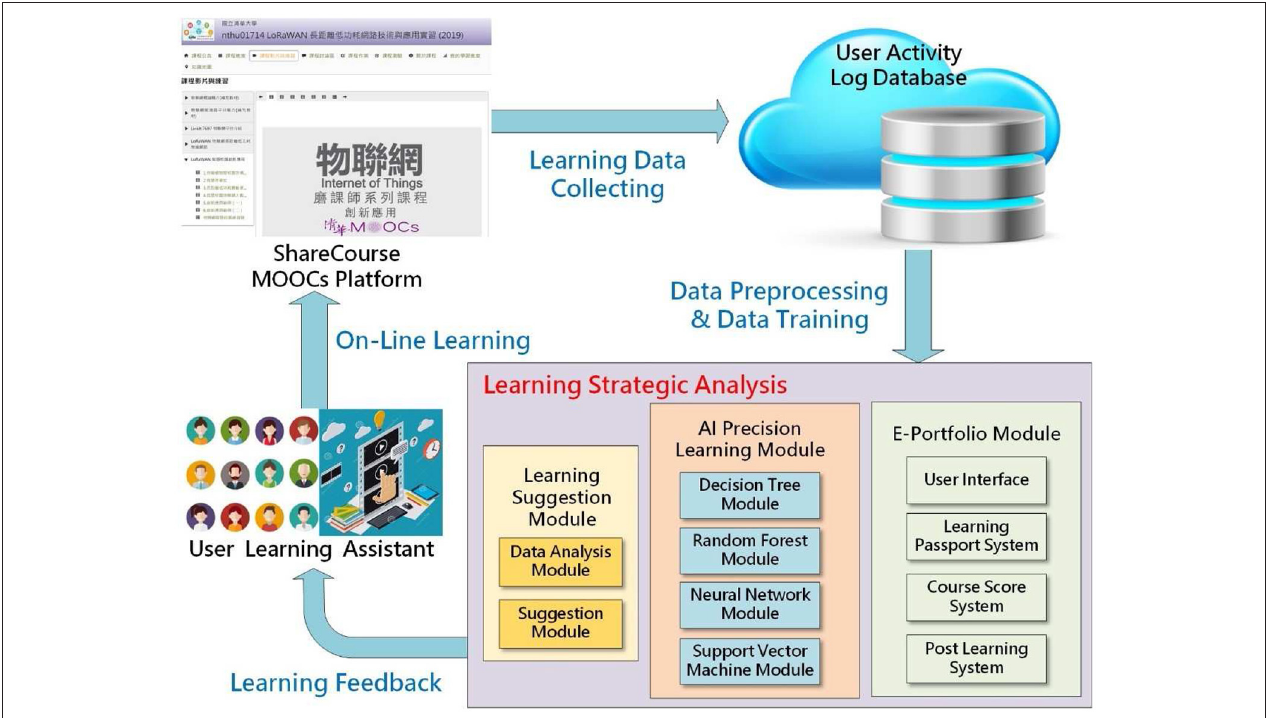
FIGURE 1 | AI precision education assisted learning teaching